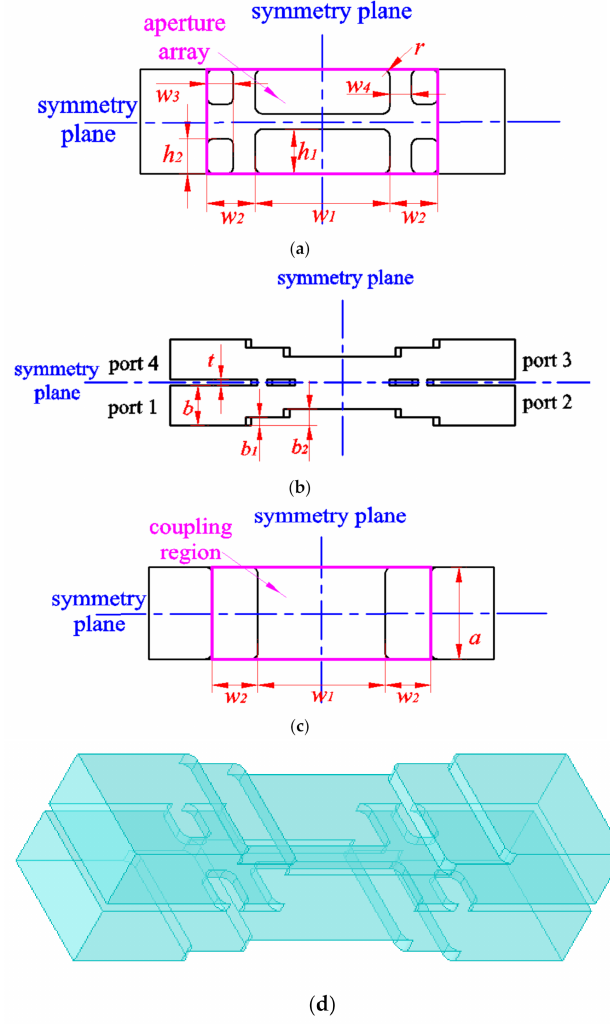
Figure 1. The proposed coupler: ( a ) rectangular aperture array, ( b ) side view, ( c ) top view, and ( d ) 3D-structure